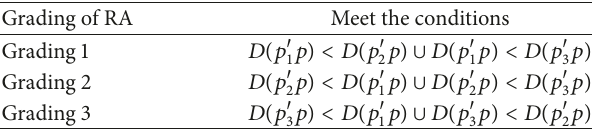
Table 6: Grading methods of